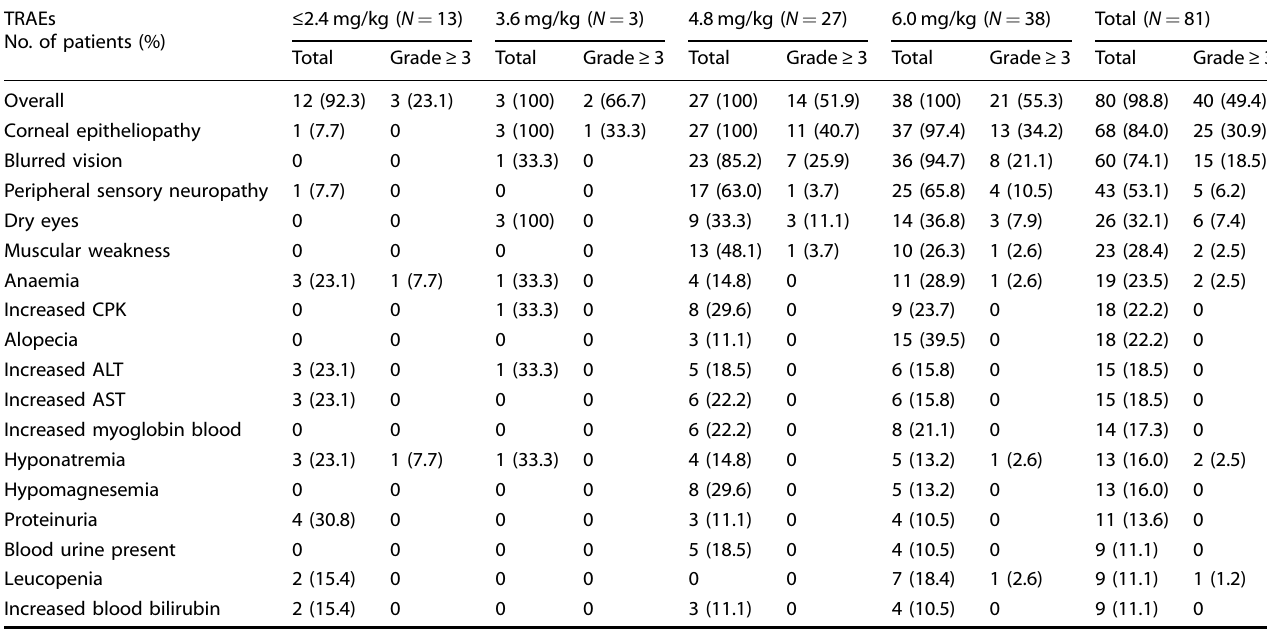
Table 2. Most common TRAEs (any and grade ≥ 3) that occurred in 10% or more patients. TRAEs No. of patients